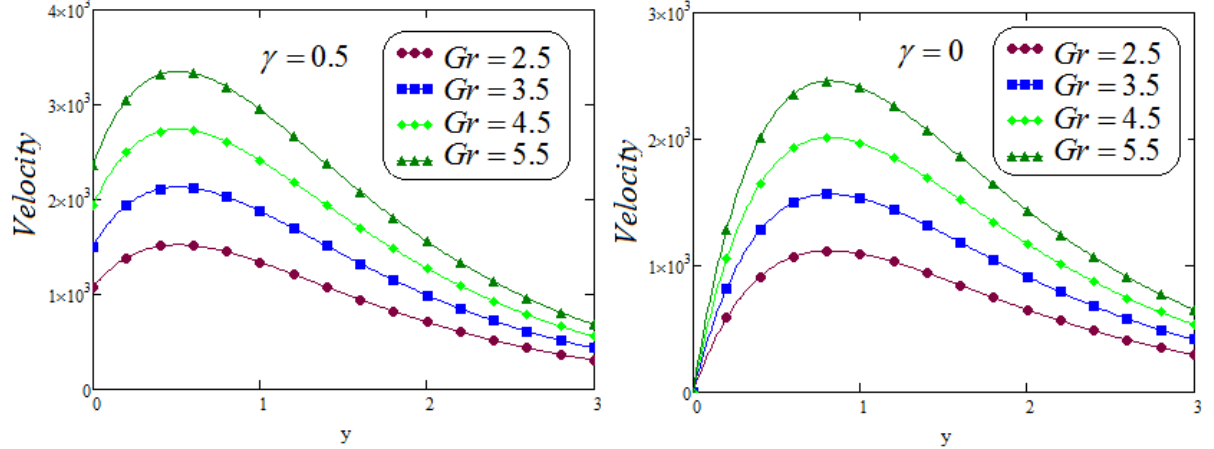
Figure 12. Velocity for varied values of G r with and without slip effect γ when f ( t ) = sint , t = 1.5, α = 0.5, β = 0.3, P r = 0.71, λ 1 = 0.6, λ 2 = 0.2, M = 2.